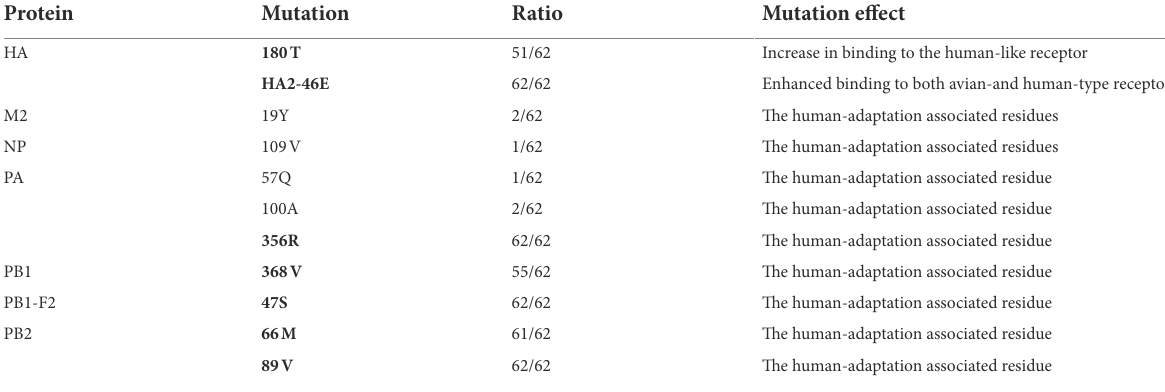
TABLE 2 The human-adaptation-related molecular markers identified in the newly sequenced H9N2 virus strains. Protein Mutation